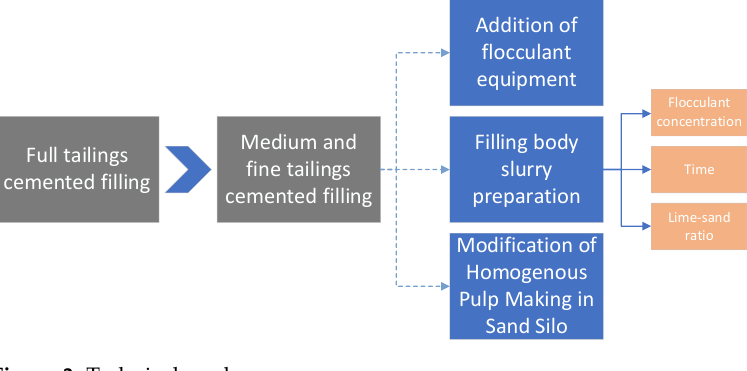
Figure 3. Technical roadmap.